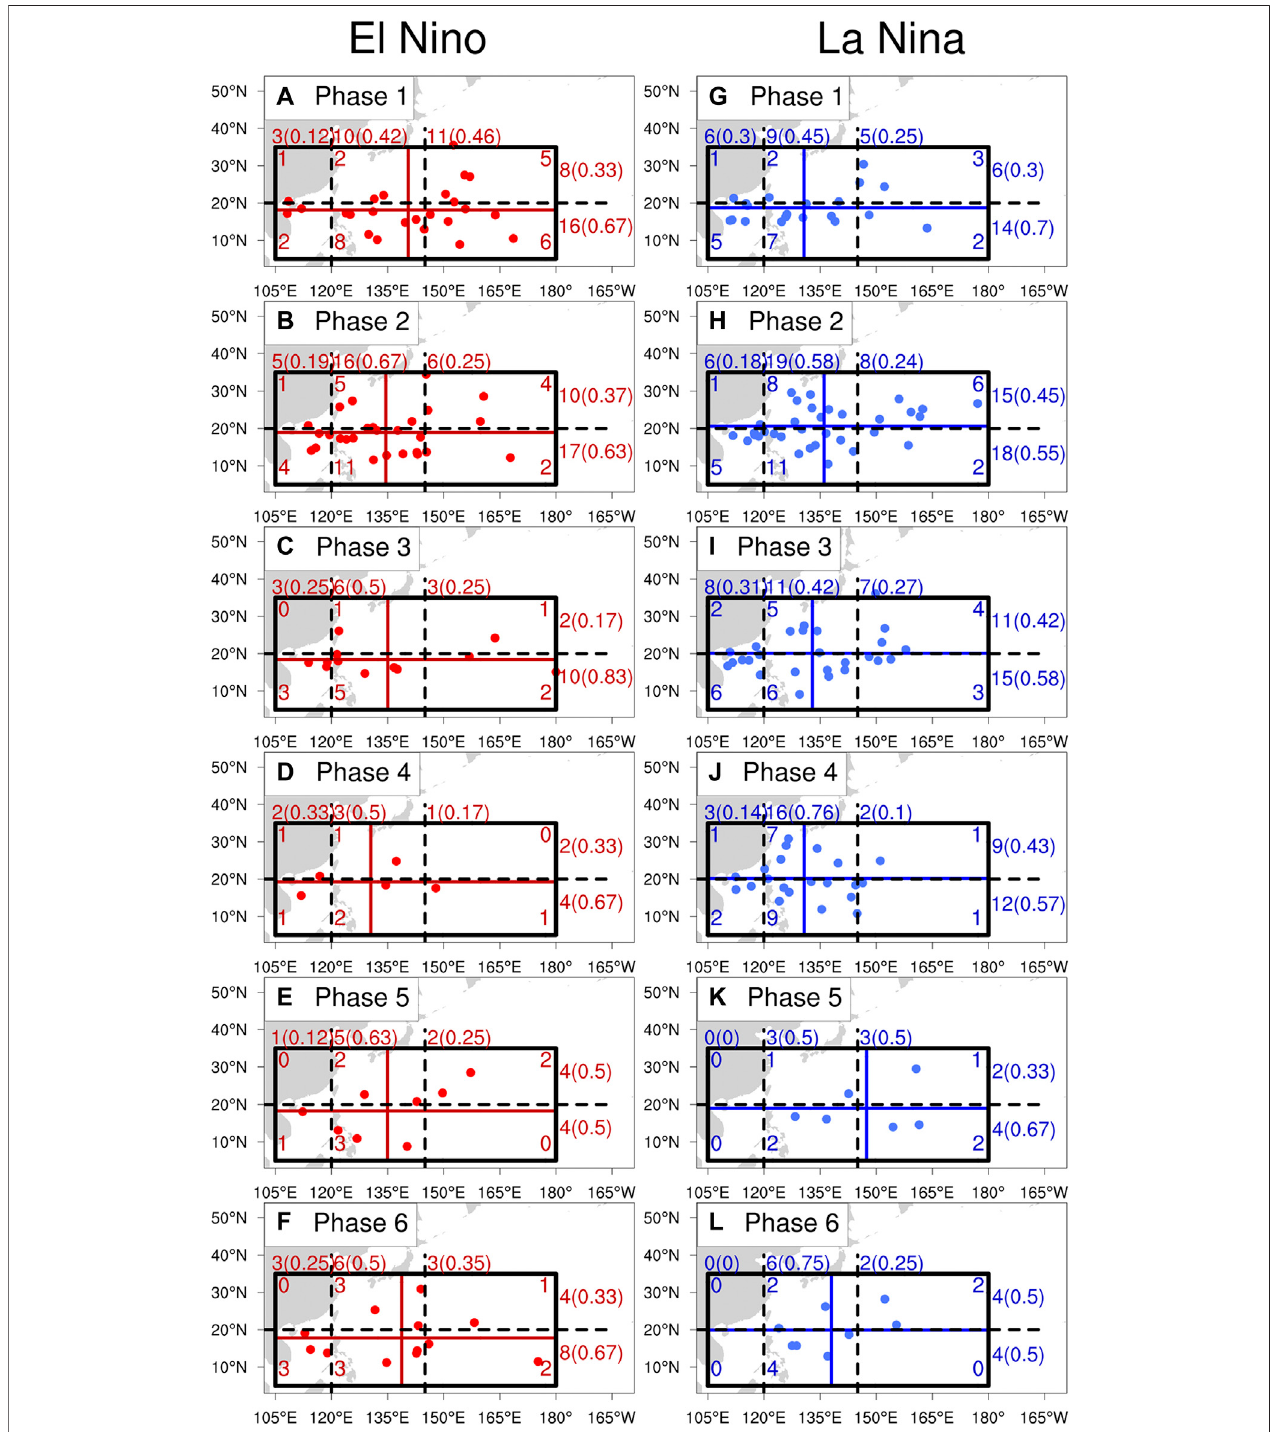
FIGURE7| ThepositionsofmultipletropicalcyclogenesisduringJunetoSeptemberindifferentphasesofEAPoscillation.Thepointsandnumbersinred(blue)are forElNiñoEAP(LaNiñaEAP).Theblackframeinsolidlinedistinguishesthedomainwhereallmultipletropicalcycloneeventstakeplacewith6sub-domainsdividedbya zonal dashed lineat 20 ° N and two meridional dashed lines at 120 ° E and 145 ° E.The numbers in the sub-domain show the amount ofMTCs which generate inside, while the numbers lying north or east to the frame denote the summary of the MTCs generating in the corresponding meridional or zonal bands with the percentage in